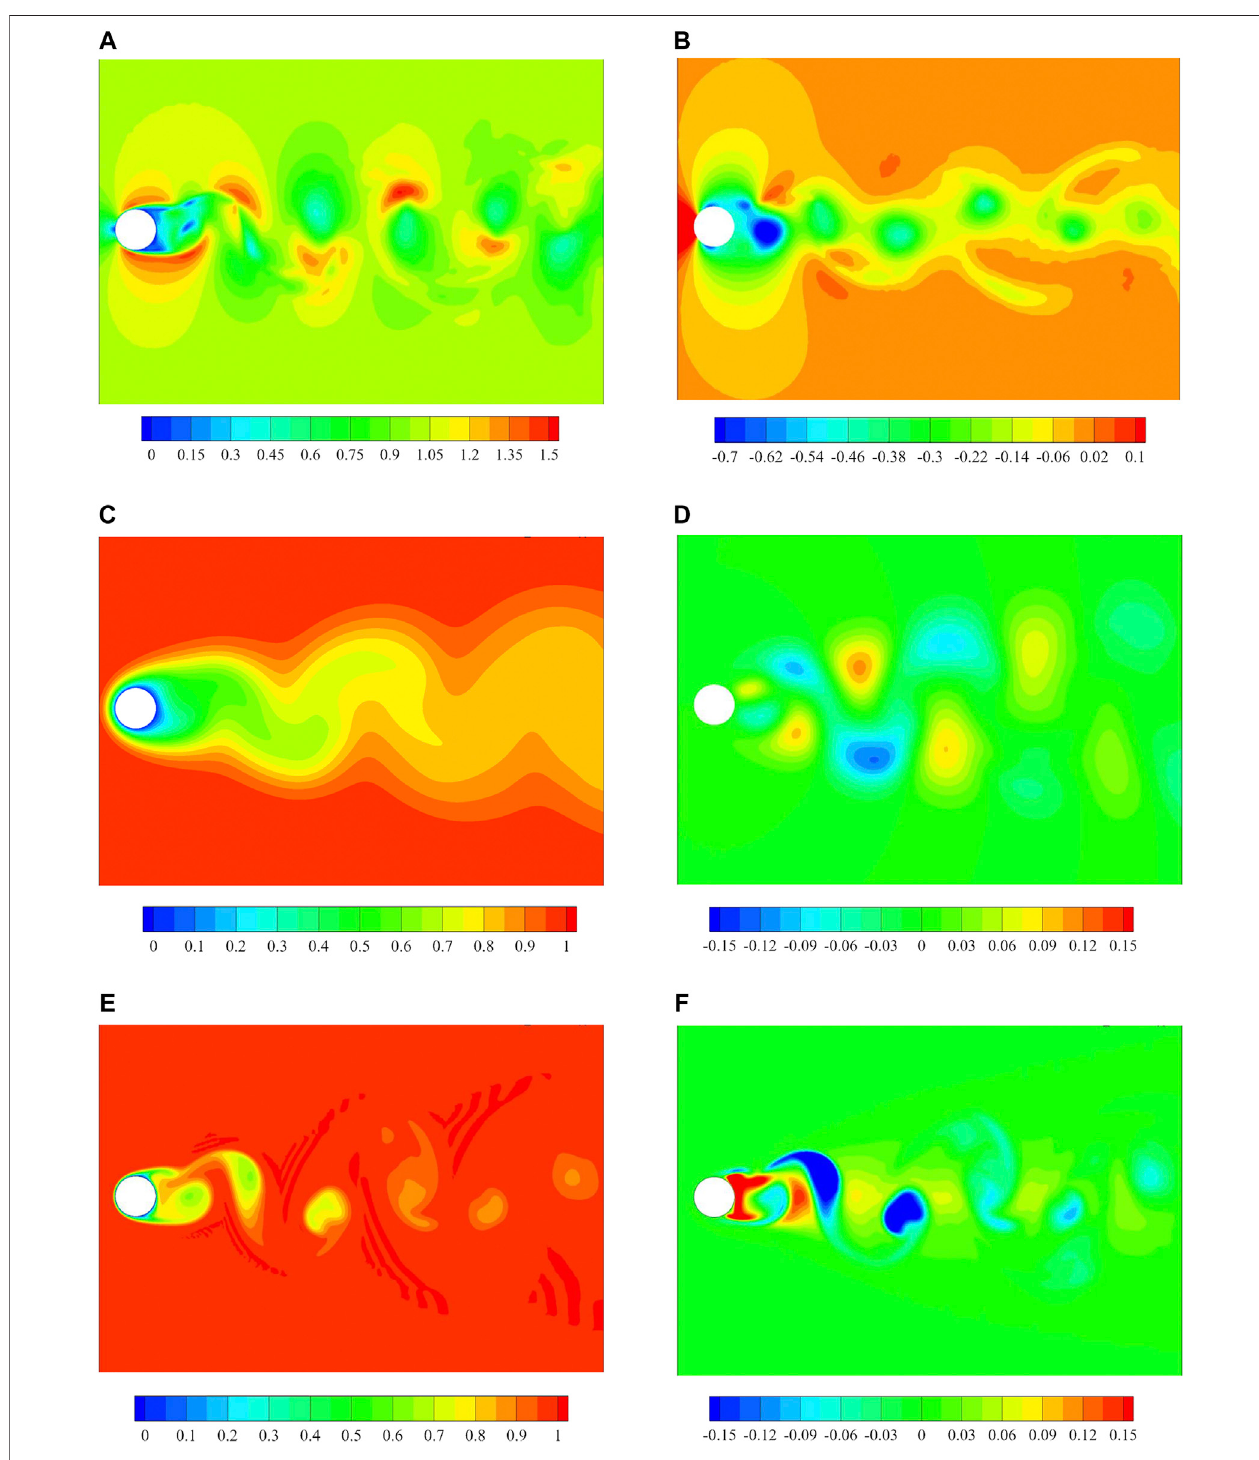
FIGURE 4 | Distributions of pressure, velocity and temperature at a typical moment (at z = 0 plane). (A) Magnitude of velocity; (B) pressure; (C) transient temperature (LBE, Pr = 0.025); (D) fl uctuating temperature T ′ ( T ′ = T − (cid:1) T )(LBE,Pr = 0.025); (E) transienttemperature(air, Pr = 0.71); (F) fl uctuatingtemperature T ′ (air, Pr = 0.71).